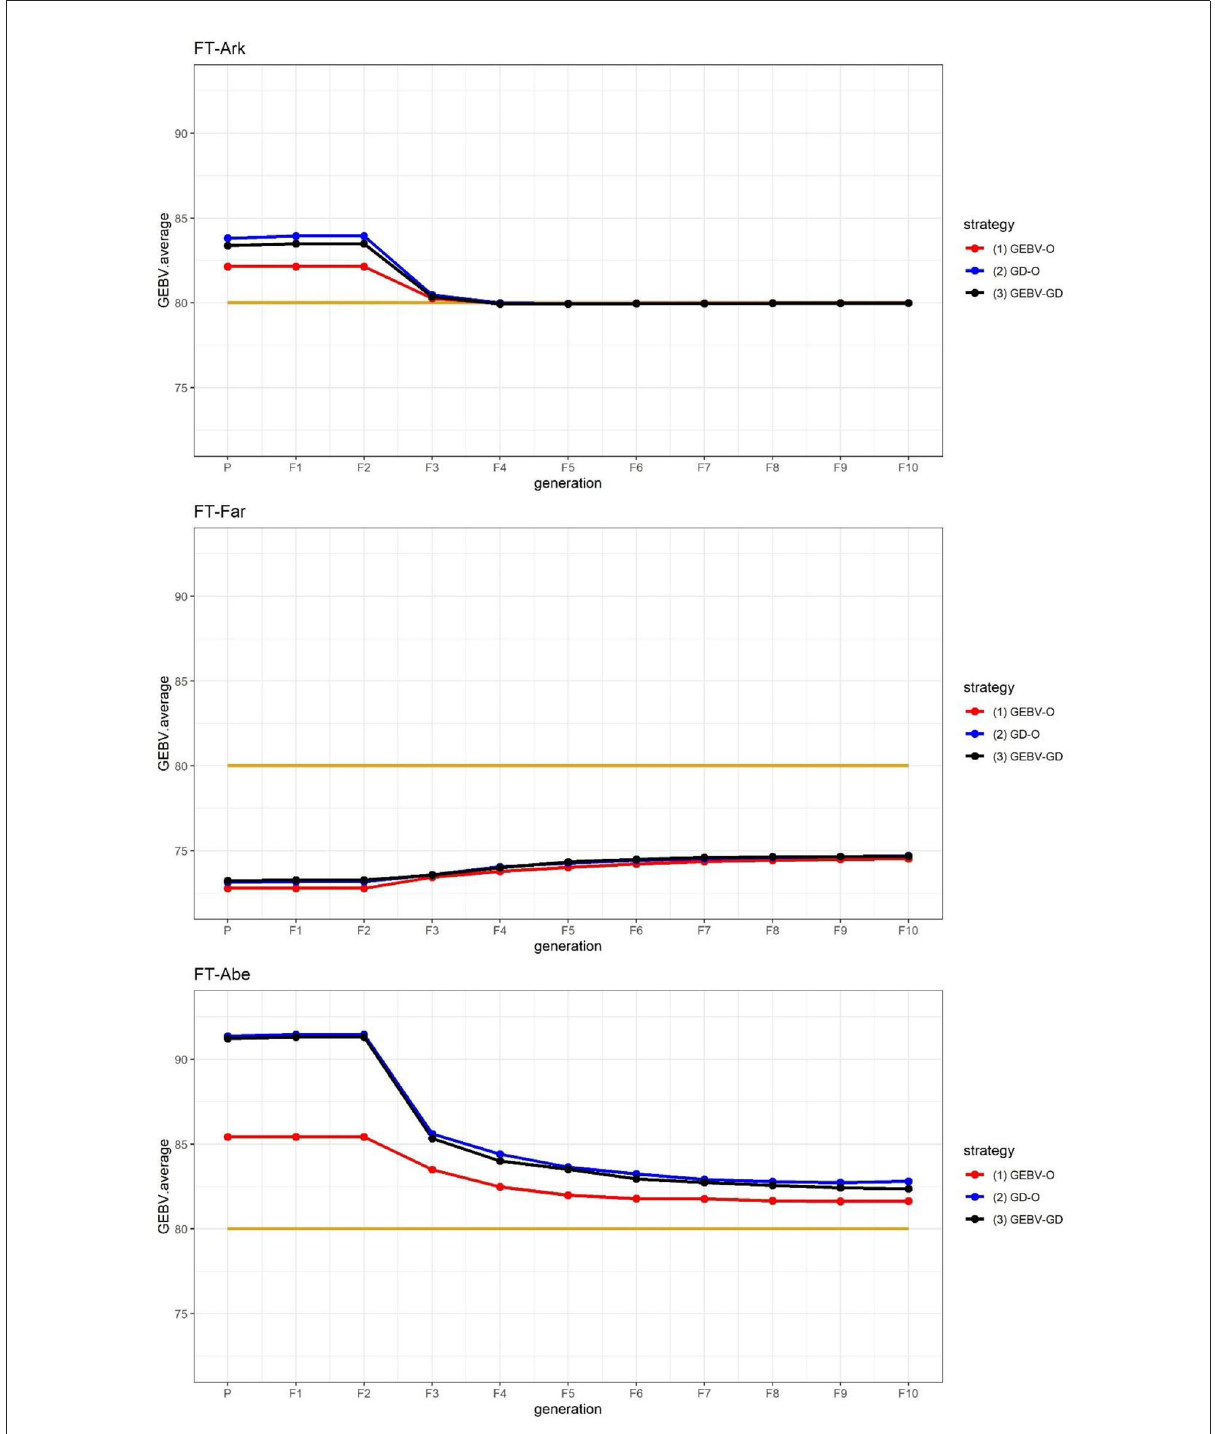
FIGURE2 GEBV averages of the best individuals at each generation for the 44k rice dataset based on the index weights of 1/3, 1/3, and 1/3. GEBV-O, Subset of the 10 accessions with the highest selection index values; GD-O, Subset of the 10 accessions with the maximal D -scores chosen from the candidate set S c ; GEBV-GD, Subset of the top two accessions with the highest selection index values, and another eight accessions chosen from the reminder of S c . FT-Ark, flowering time in Arkansas; FT-Far, flowering time in Faridpur; FT-Abe, flowering time in